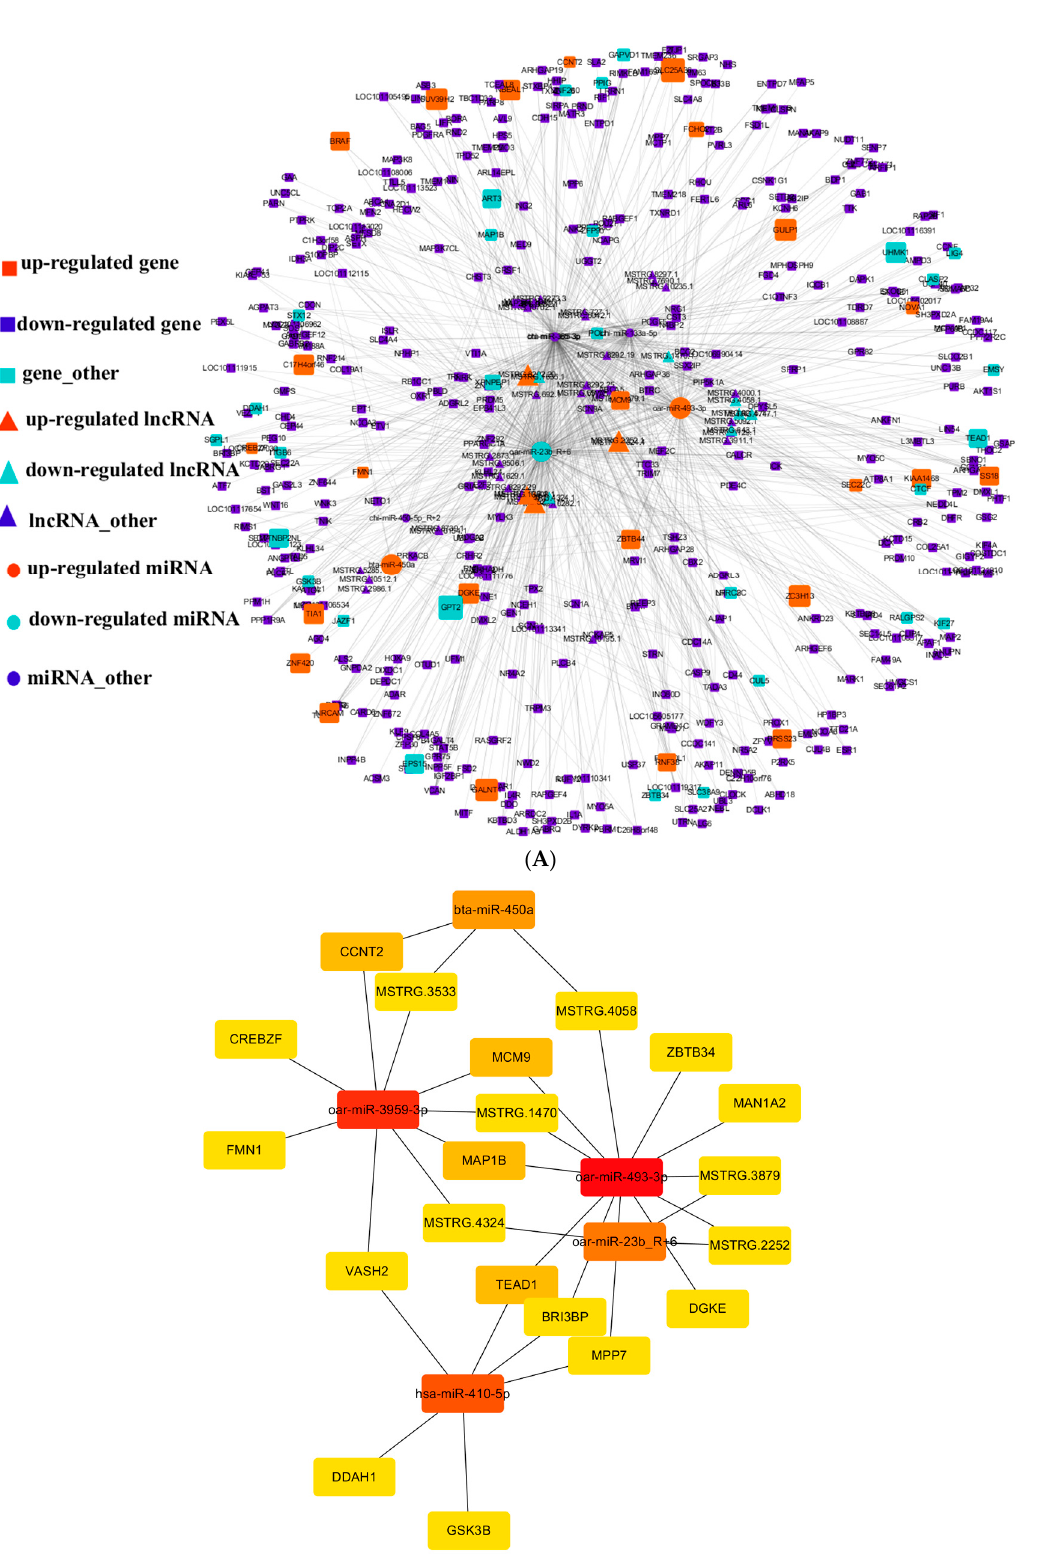
Figure 2. The ceRNA network in the muscle: ( A ) triangles represent lncRNAs, round rectangles represent target genes, and ellipses represent miRNAs, where red represents upregulated expression, green represents downregulated expression, and purple represents neither up- nor downregulated expression; ( B ) a subnet of the ceRNA network.